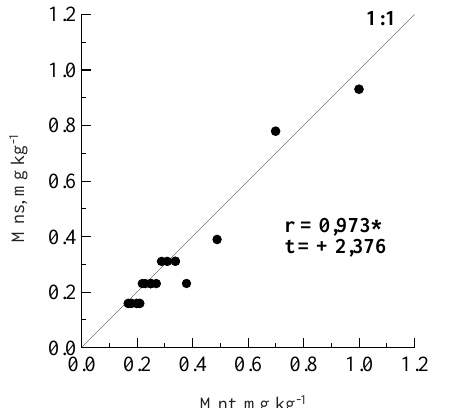
Figura 2. Relação entre os teores de manganês obtidos por ataque sulfúrico (Mn fluorescência de raios-X (Mn corresponde a uma inclinação de 45 °, passando pela origem.